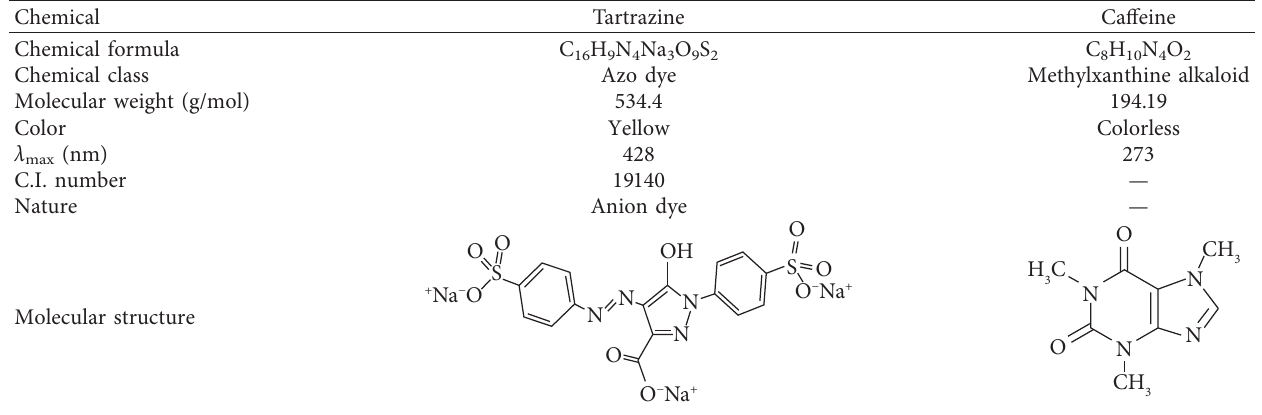
Table 1: The basic characteristics of tartrazine and